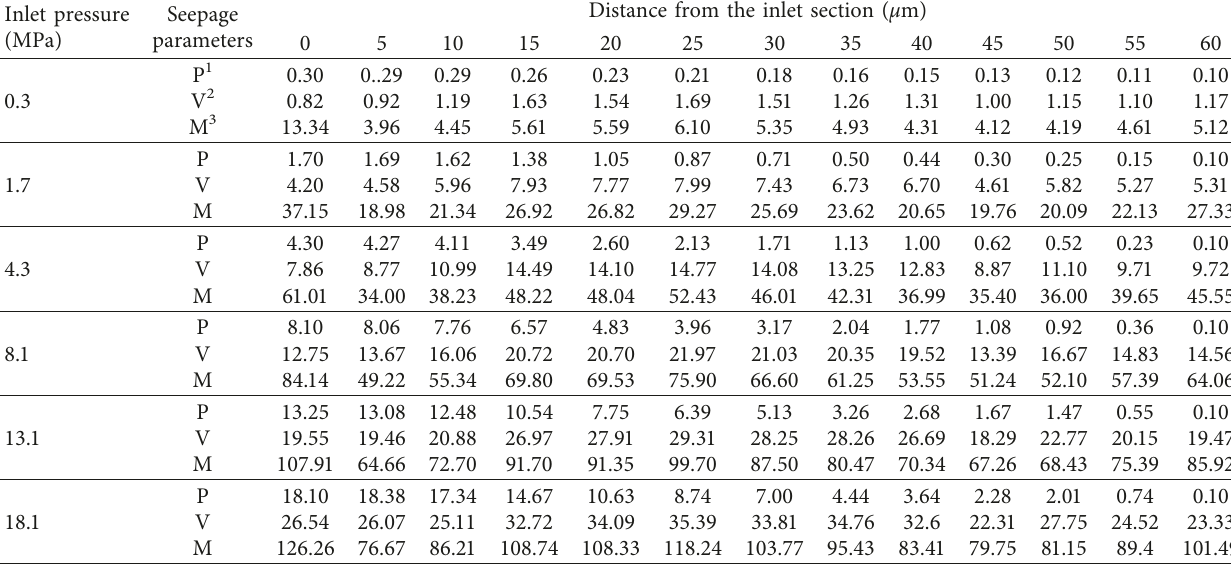
Table 5: Simulated results of average seepage pressure, average seepage velocity, and average mass flow on each section under different inlet pressures.